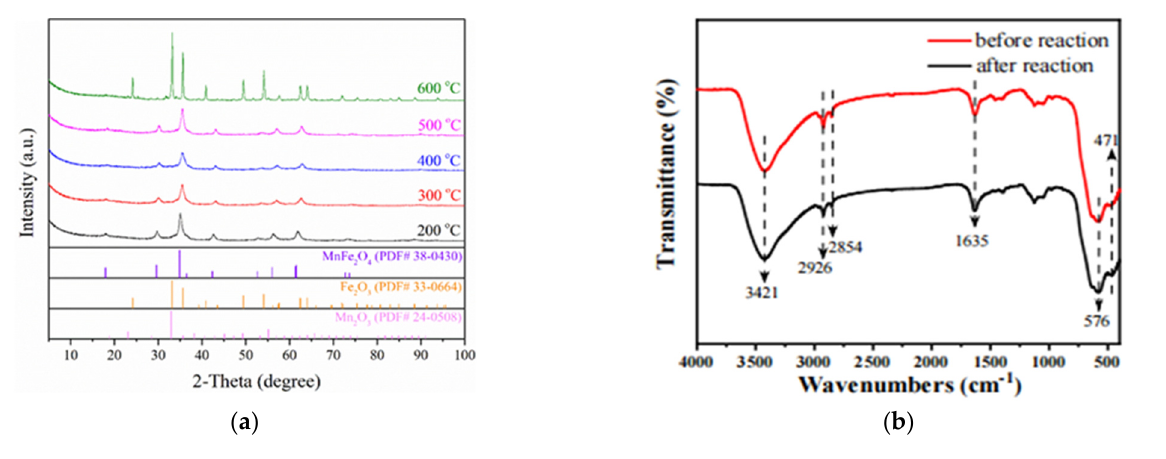
Figure 1. ( a ) XRD patterns of MnFe 2 O 4 at different calcination temperatures; ( b ) FTIR spectra of MnFe 2 O 4 before and after the reaction.